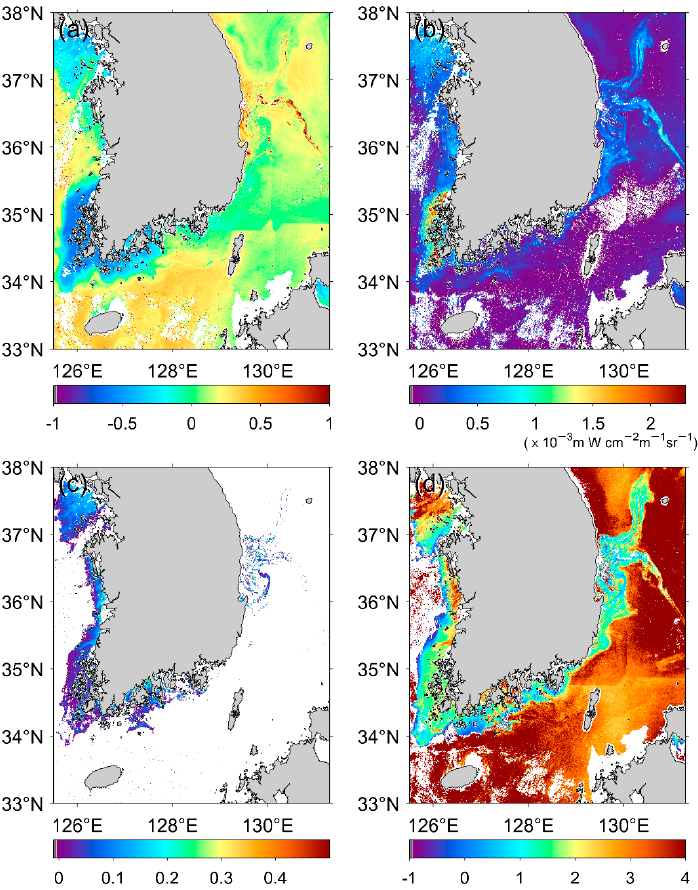
Figure 8. Spatial distribution of the red tide index as a result of applying previous methods of ( a